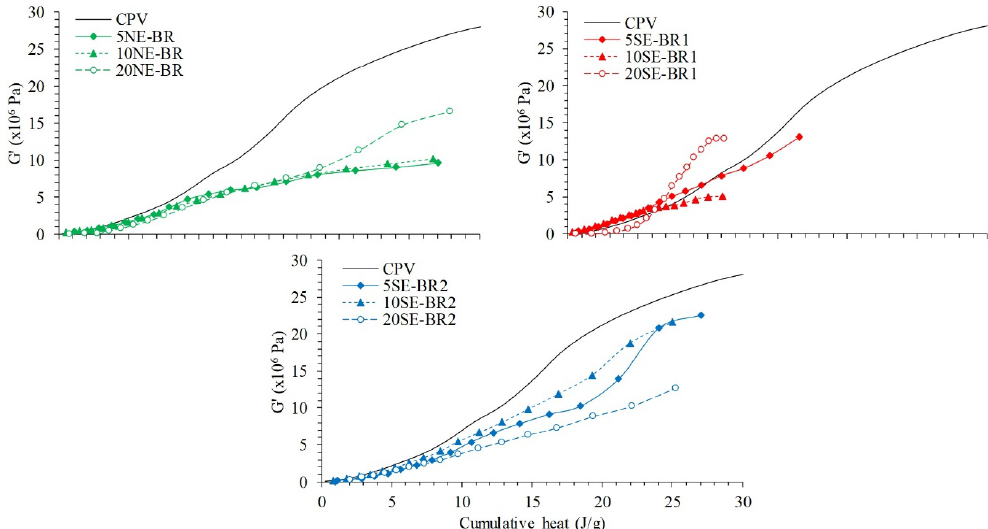
Figure 9 M onitoring the hardening stage combining the results of oscillatory rheometry and isothermal calorimetry. In above is presented the results for NE-BR, in the middle for SE-BR1 and below for